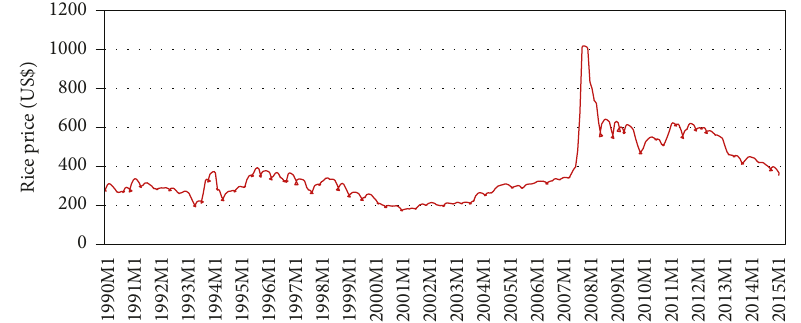
Figure 1: Time plot for rice price (unit: US dollars per metric ton).